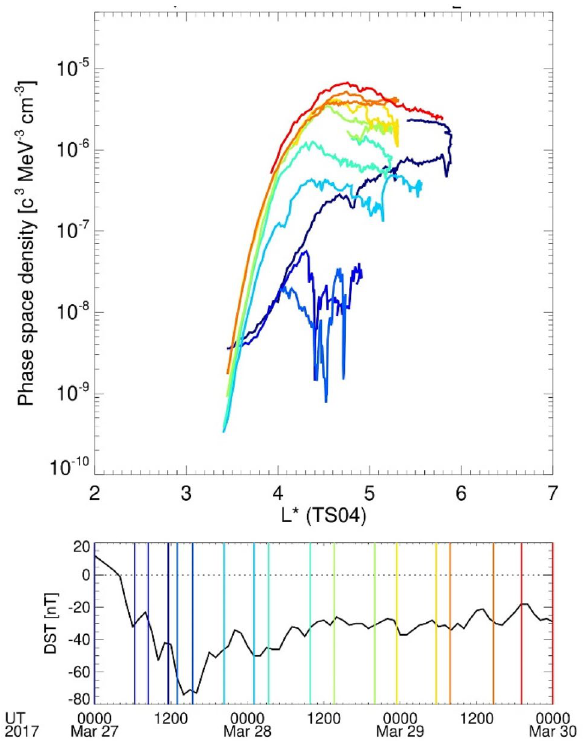
(c/cm MeV) 3 , where c is the speed of light. By plotting phase space density at fixed magnetic adiabatic invariants, μ = 1000 MeV/G, and K = 0.2 R E G 1/2 . The invariants were calculated using the TS04 magnetic field model 49 . Corresponding energy and pitch angle for μ = 1000 MeV/G, and K = 0.2 R E G 1/2 are shown in Fig. S1 (Bottom). The storm index Dst. Colour lines in top panel correspond to each period in bottom